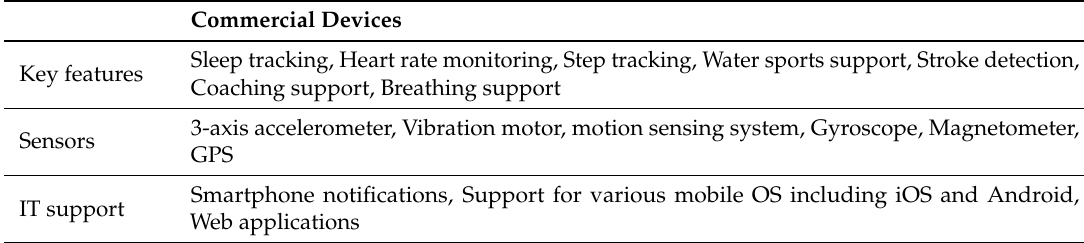
Table 2. Commercial devices in a